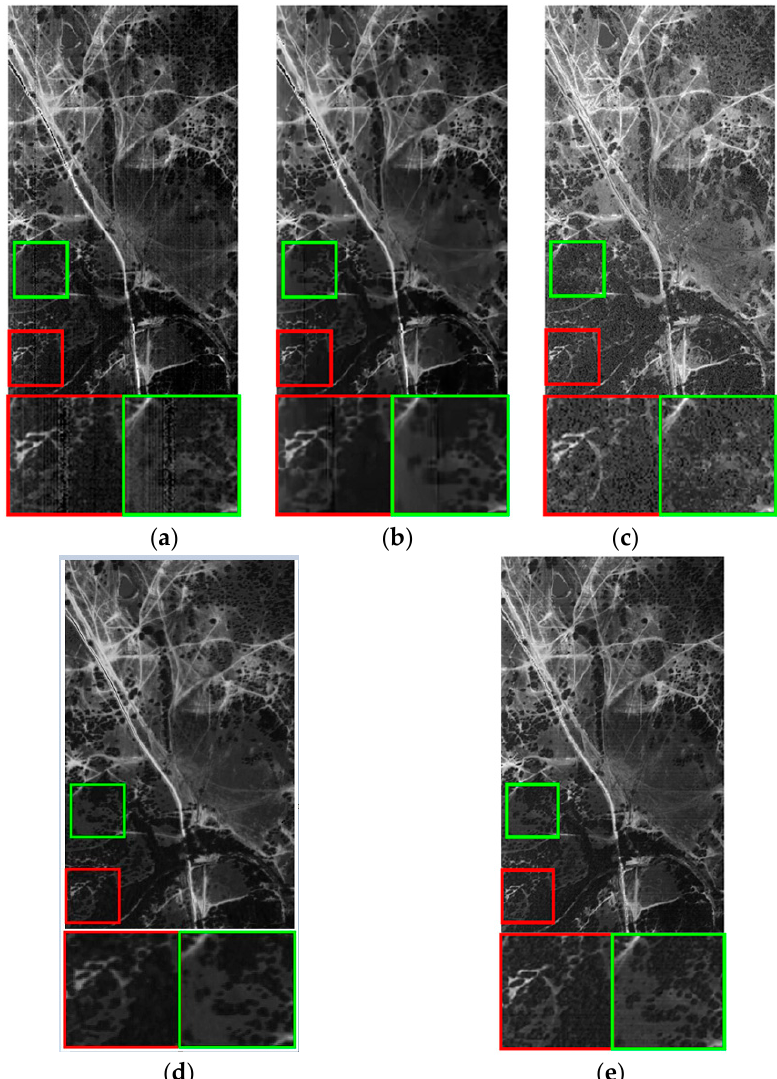
Figure 8. Visual results on band 1 of terrain dataset: ( a ) Captured actual band, ( b ) Restoration results of VBM3D based method, ( c ) Restoration results of Godec based method, ( d ) Restoration results of SLrank based method, ( e ) Restoration results of the proposed method.